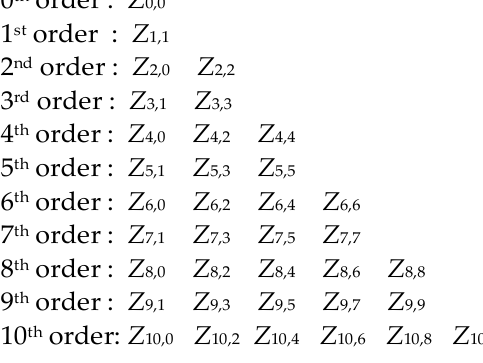
CNN algorithm, 545 catenary images were selected as the sample set, of which 484 images were randomly selected as the training set, and the remaining 61 images were used as the test set. Images are annotated with